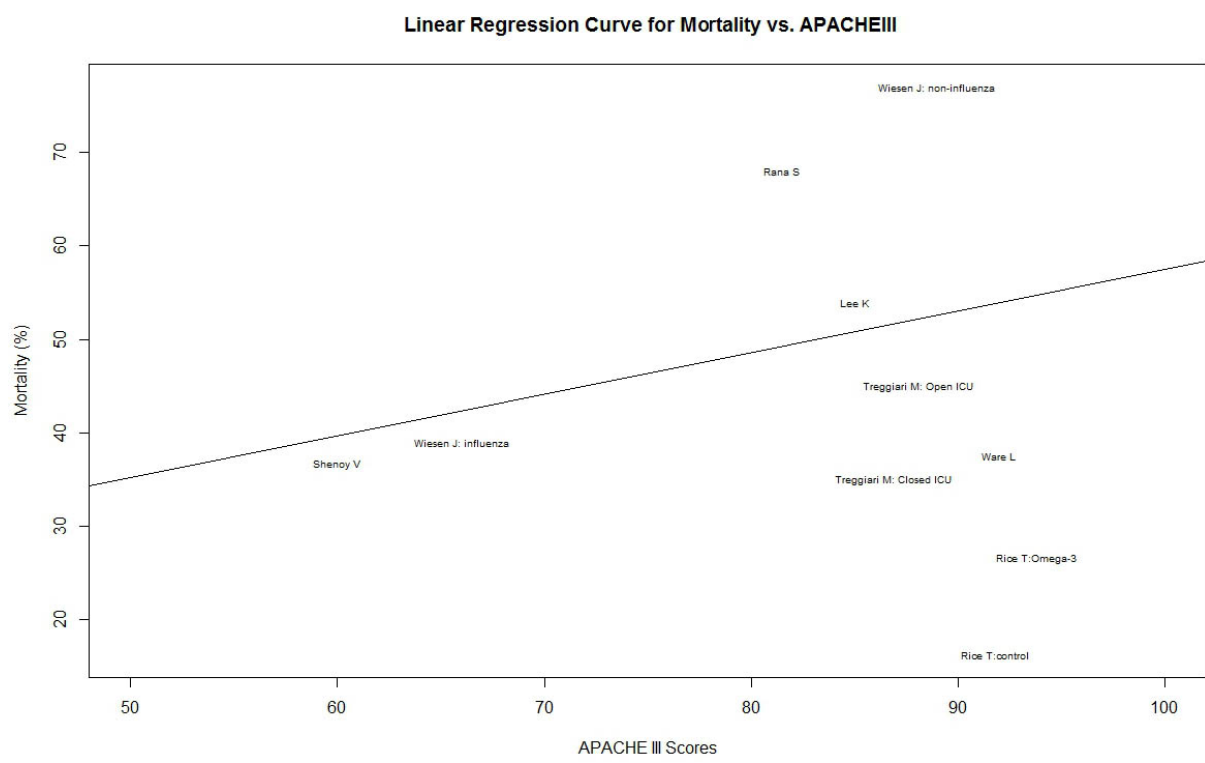
Figure 4. Heterogeneity Analysis: Linear Regression Curve for Impact on Mortality and APACHE III Scores: The horizontal axis shows the APACHE III scores, and the vertical axis shows the mortality (%). According to the data of ALI studies, a linear regression model is set up based on the APACHE III scores and the mortality. The regression equation is expressed by the straight line in the